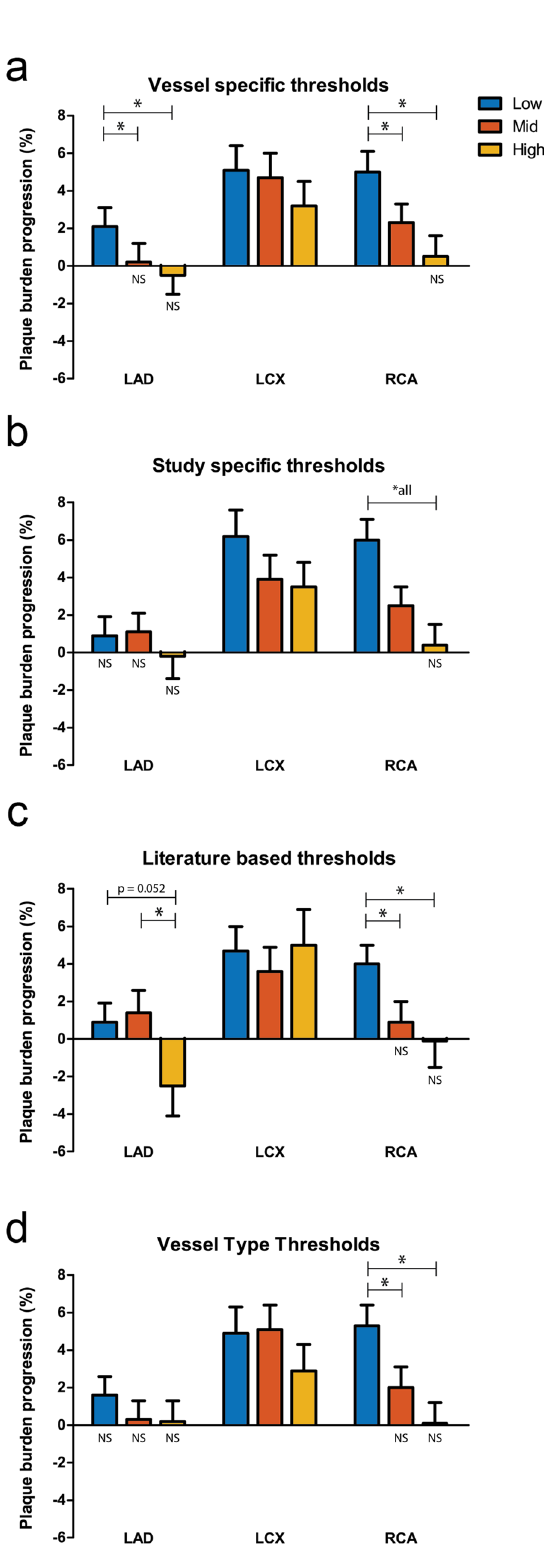
Figure 3. Wall shear stress distribution and plaque progression for the four different thresholding methodologies split up in the three coronary artery types. * p <